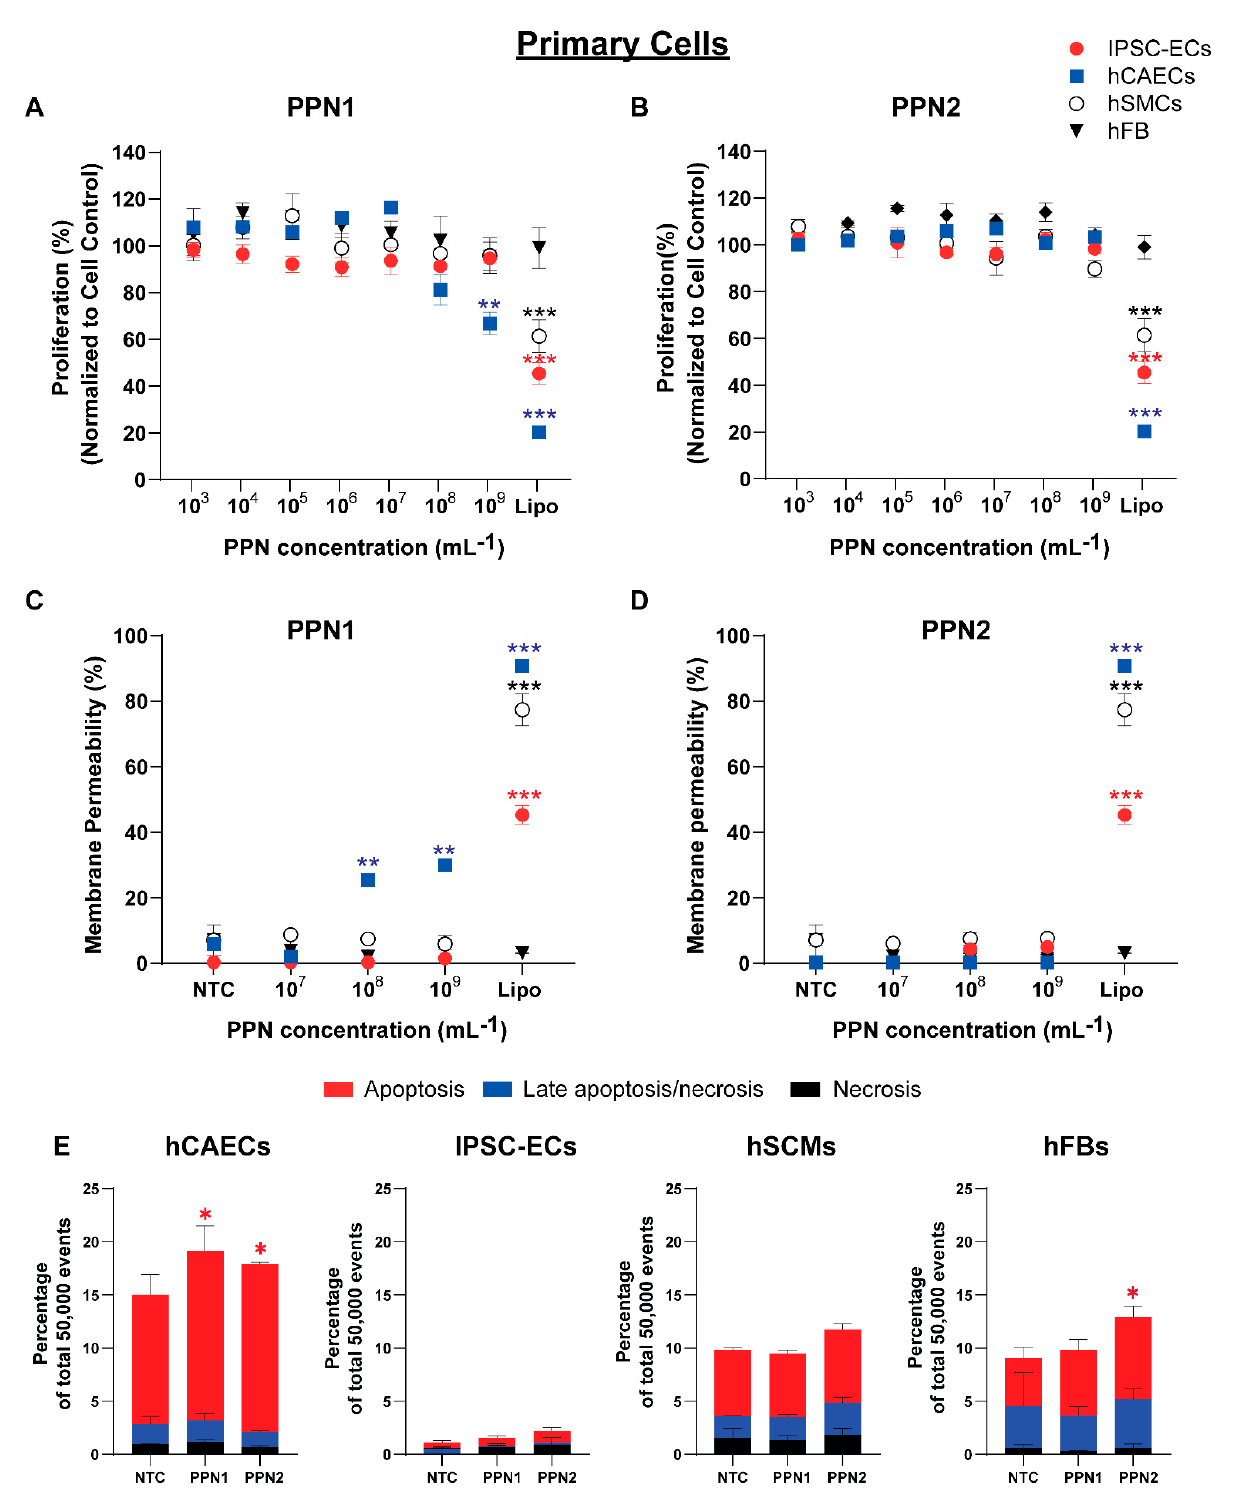
Figure 2. The effect of the size (PPN1 and PPN2) and dose of PPNs (concentration ranging 10 3 –10 9 PPN/mL on ( A , B ), cell proliferation, ( C , D ) cell membrane integrity, and ( E ) apoptosis in primary cells (IPSC-ECs, hCAECs, hSMCs, and hFBs). Untreated cells (NTC) and cells treated with lipofectamine were used as control groups. The data represent the mean ± standard deviation ( n = 4). Statistical significance was determined using Tukey’s multiple comparison test (***, ** and * represent p < 0.001, p < 0.01 and p < 0.05, respectively).